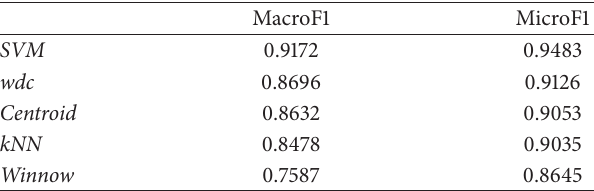
Table 3: MacroF1 and MicroF1 results.